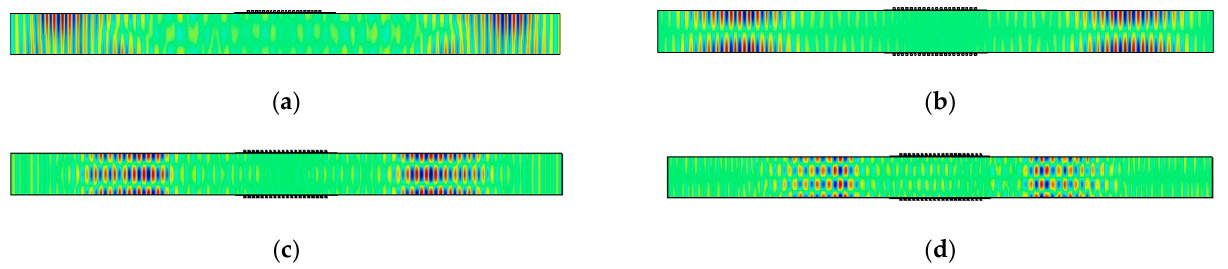
Figure 10. Double-sided MST/plate model includes the plate, two patches, and two 10-turn coils.